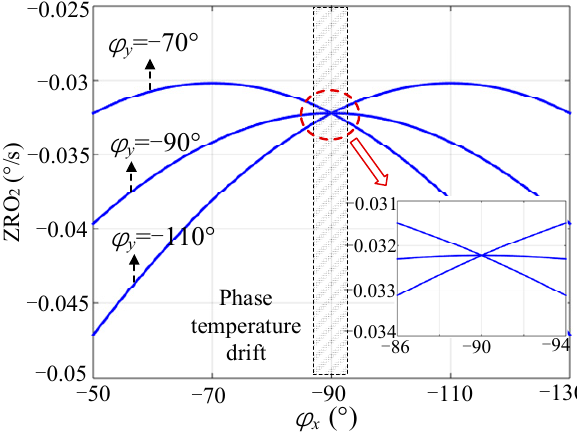
ϕ ϕ ZRO and y on 2 .